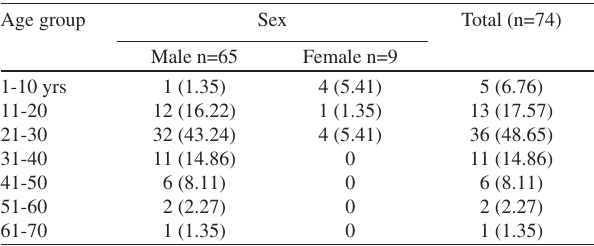
Table 3 - Distribution of patients’ age and sex in relation to road traffic accidents